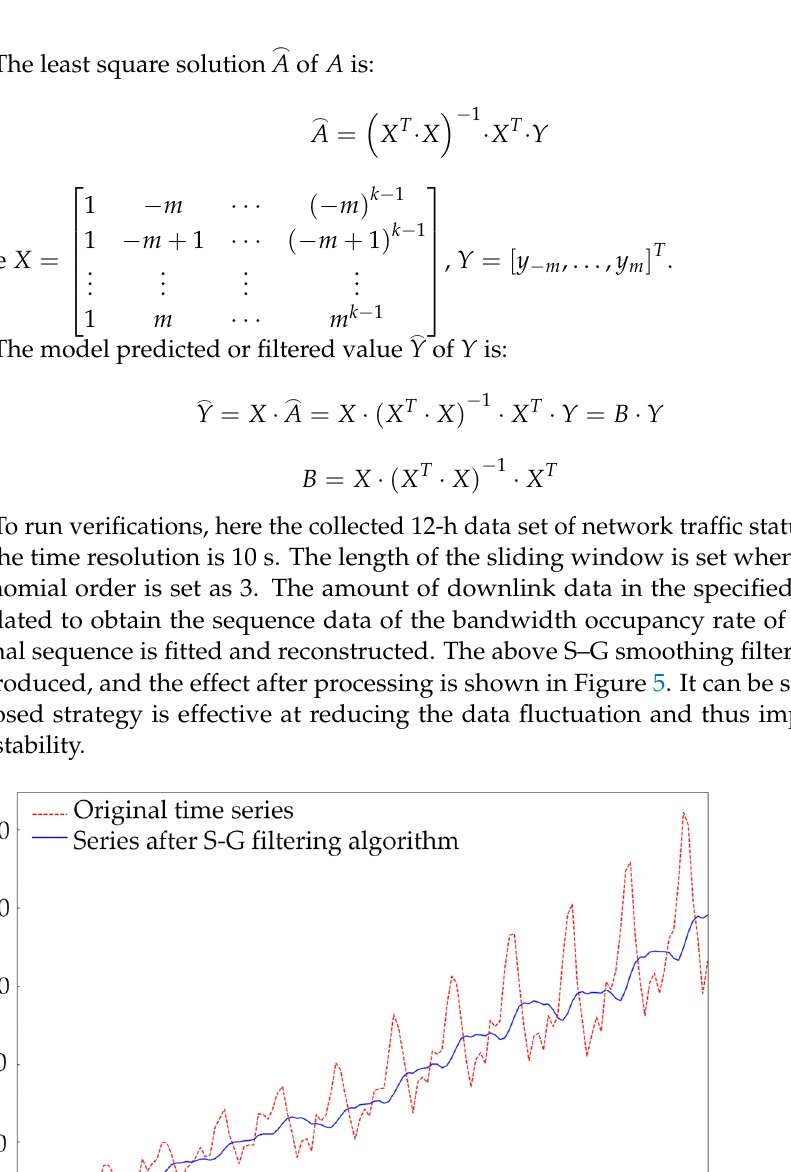
Figure 6. The autocorrelation diagram of the bandwidth occupancy rate of link j l .